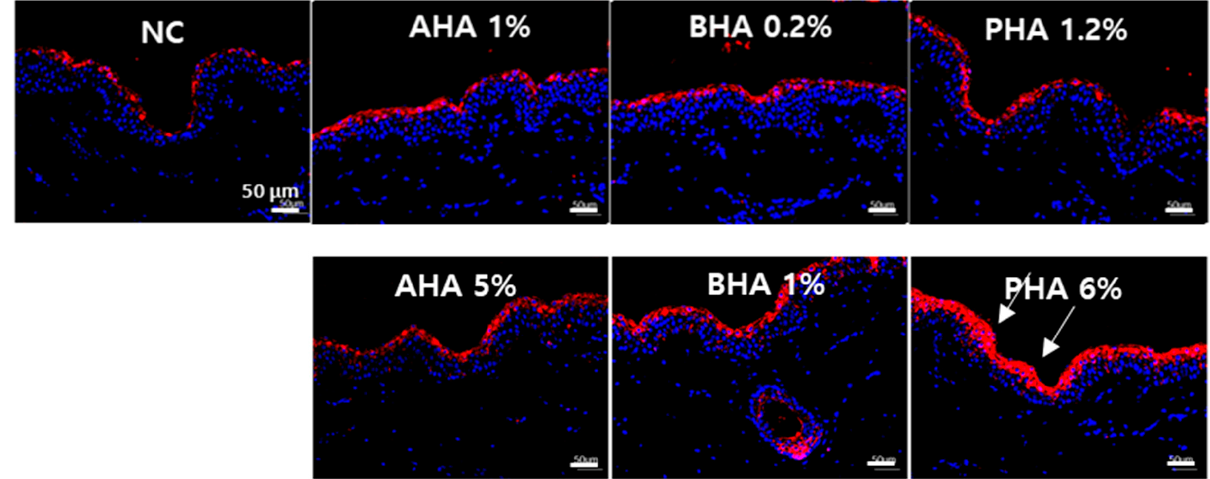
Figure 7. Immunofluorescence staining of tight junction protein, claudin 1, in the skin epidermis. Immunofluorescence images of ex vivo porcine skin with antibodies against tight junction protein, CLDN1: claudin 1 is shown in red and DAPI is shown in blue.